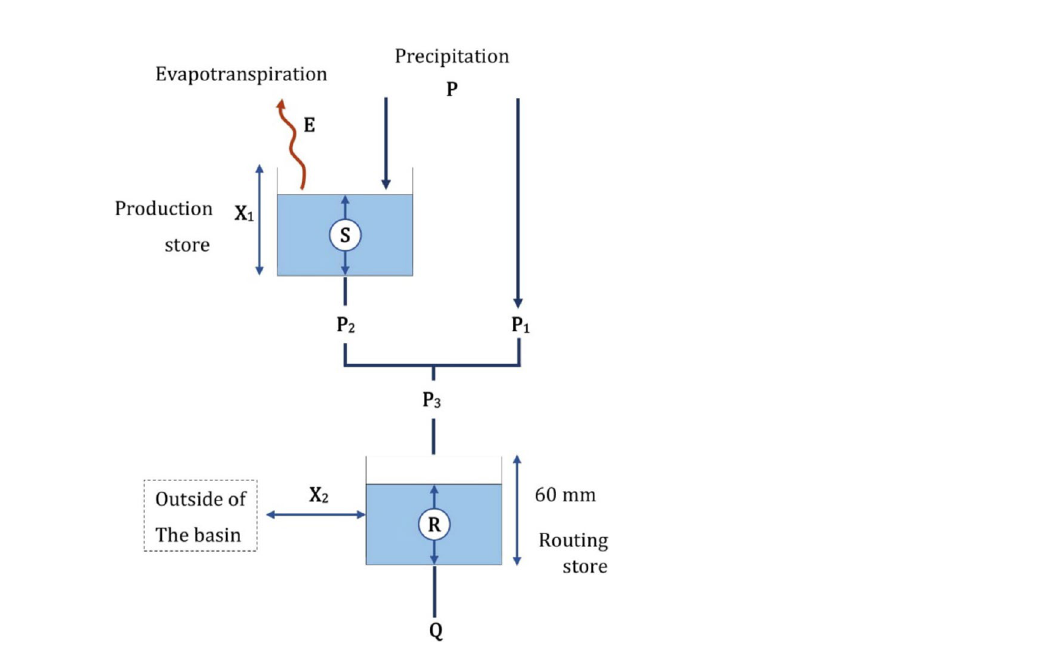
Figure 2. The GR2M model working process. Source : Adapted from Bachir et al. 38 , Rwasoka et al. 39